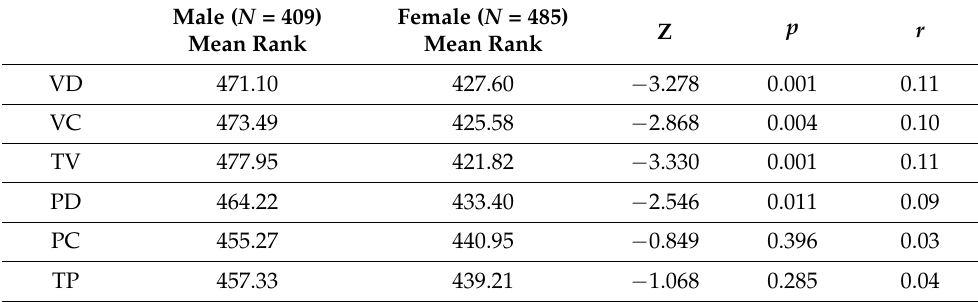
Table 2. Comparative analysis of victimization and perpetration by sex.